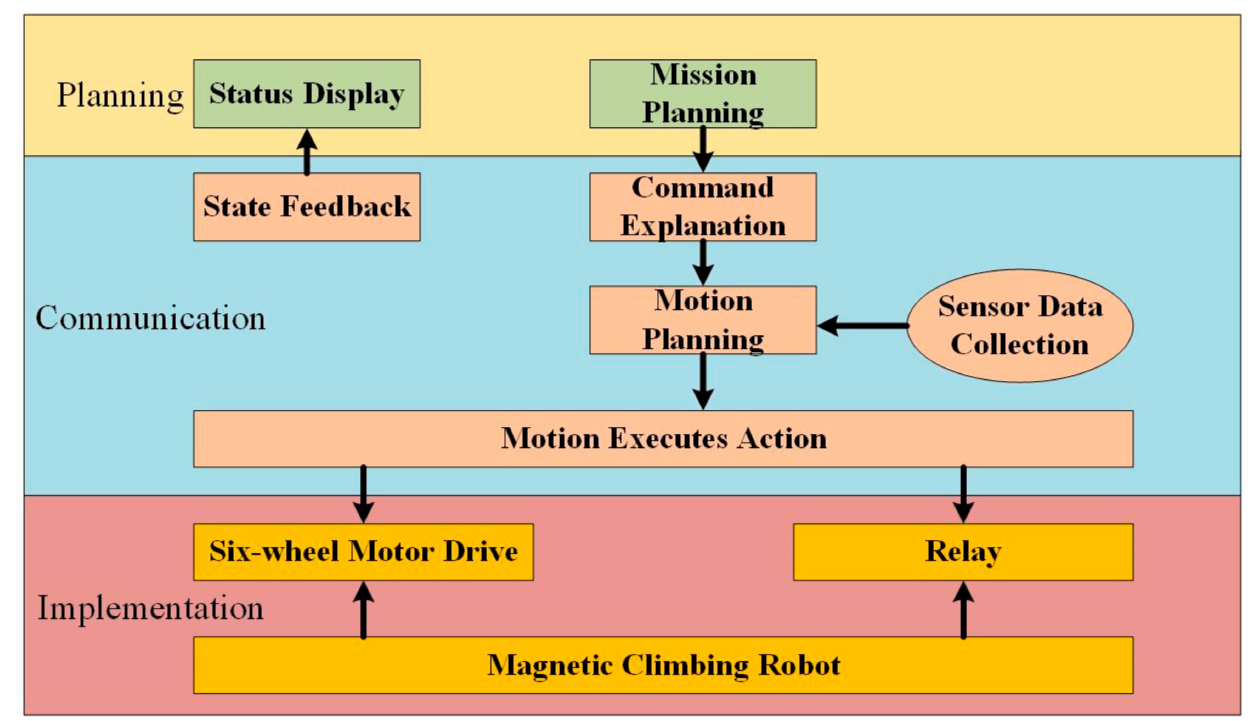
Figure 5. Schematic diagram of robot software